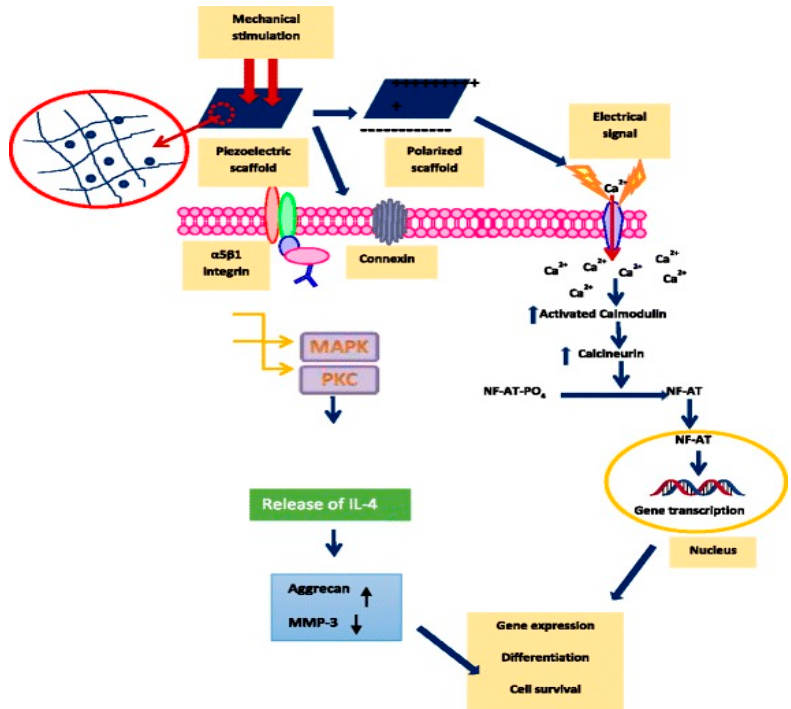
Figure 1. Schematic diagram showing the activation of Ca 2+ signal transduction pathway and other miscellaneous pathways in response to the electrical and mechanical stimulations. Ca 2+ is an important signal transducer.